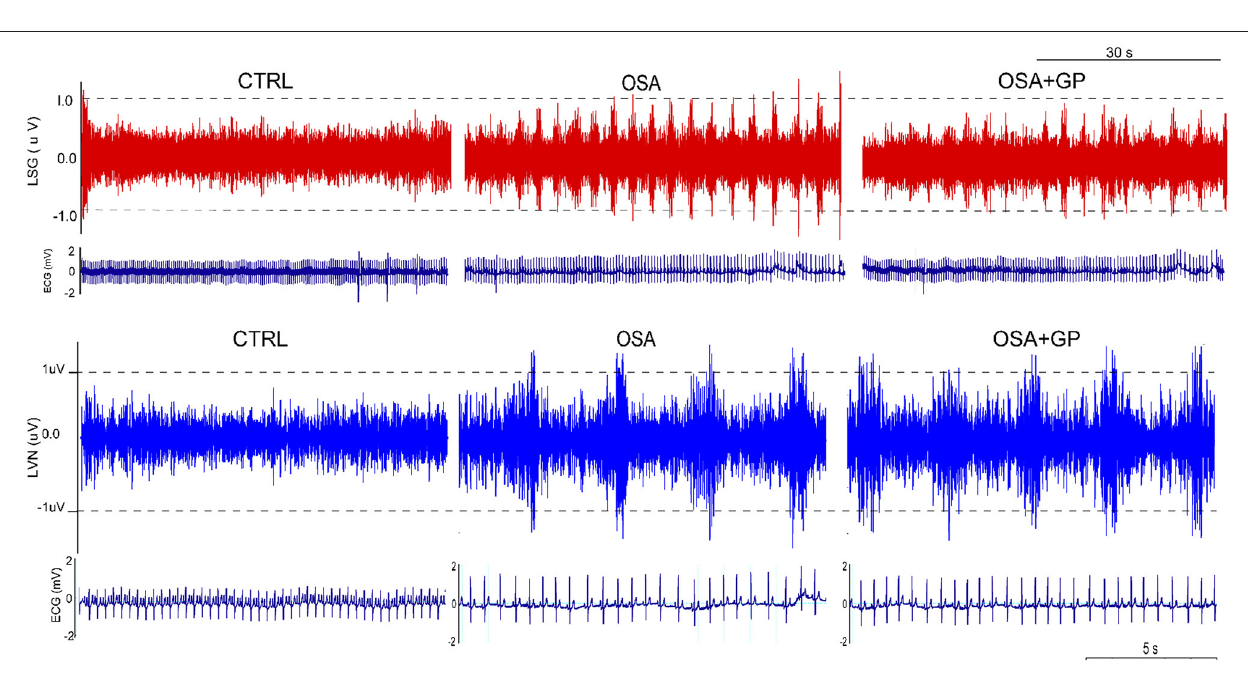
FIGURE 9 | Effect of GP ablation on the neural activity. Representative examples of neural recordings from the LSG and LVN in different groups at the 12th week. LVN, left vagal nerve; LSG, left stellate ganglion; other abbreviations as in Figure 1